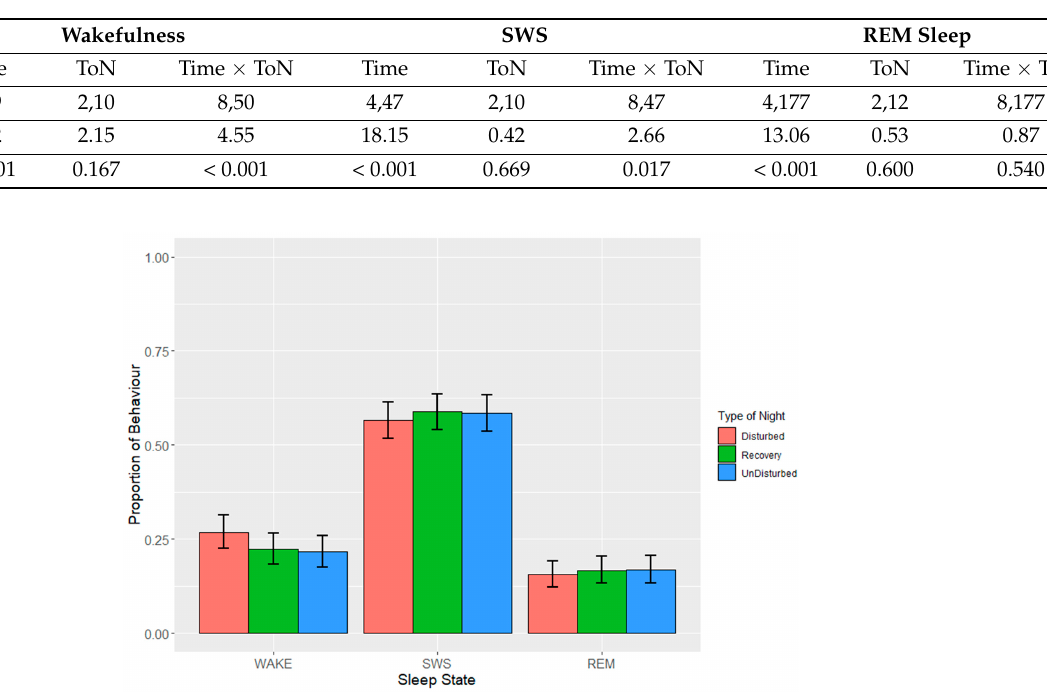
Table 5. F tests for effects of time interval (‘Time’, 2 h blocks), type of night (‘ToN’; disturbed, recovery and undisturbed) and their interaction (Time × ToN) on wakefulness, slow-wave sleep (SWS) and rapid eye movement (REM) sleep during lights off from LMMs. F values, with numerator and denominator degrees of freedom (ndf,ddf, respectively), are shown.